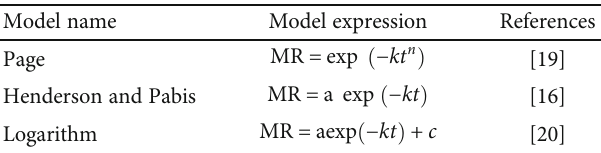
Table 1: Mathematical models that were applied to the experimental